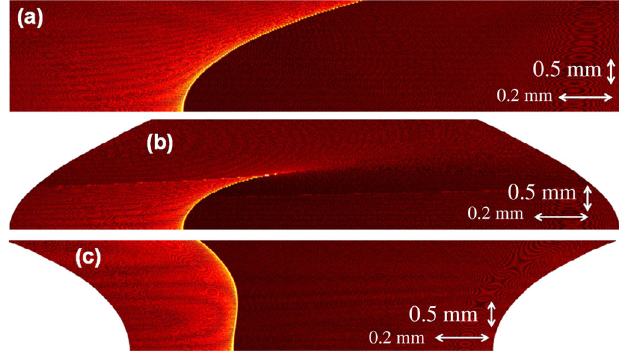
FIG. 3. Nonparaxial accelerating wave packets as they propa- gate on two kinds of surface, with (b) negative and (c) positive curvature. These wave packets propagate on various trajectories determined by the initial beam launched and the curvature of space. The propagation of the same beam on the surface of a cylinder is displayed in (a) for comparison. The spectral functions vary during propagation; in (b), at some propagation distance, the beam stops accelerating because all spectral frequencies become evanescent, and in (c), the trajectory of the beam becomes nonconvex. (The wavelength of the light in all figures is 0 . 5 μ